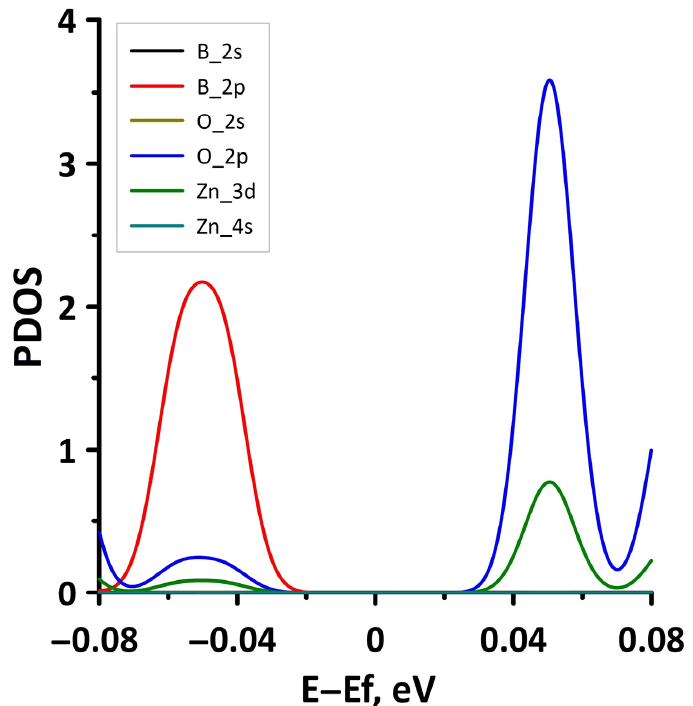
Figure 25. Fragments of PDOS near the Fermi level (shifted to 0 eV) of borophene/ZnO heterostruc- ture under biaxial compression by 6%.